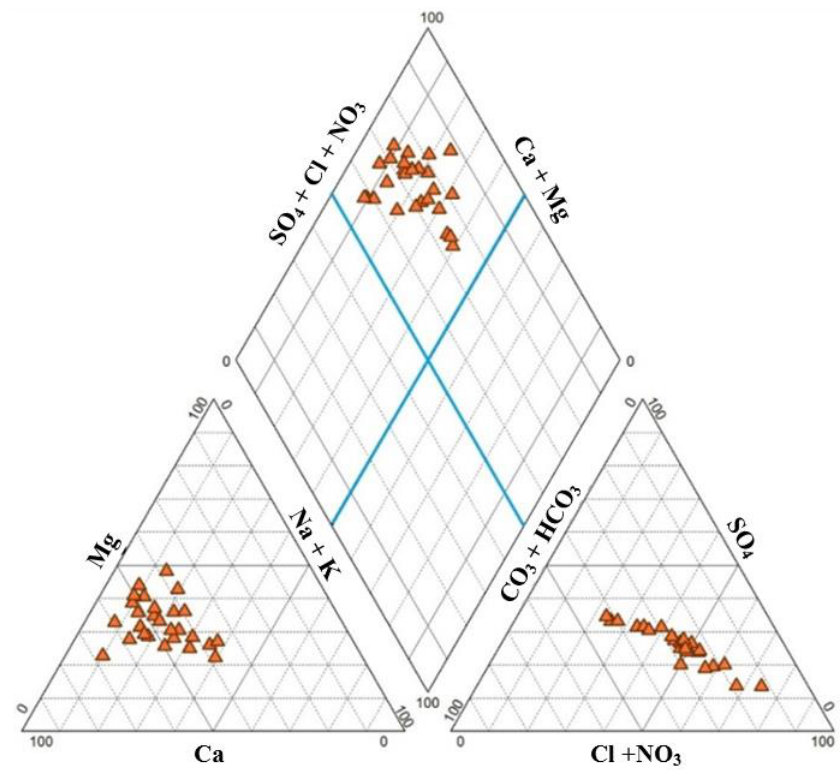
Figure 3. Groundwater facies according to Piper